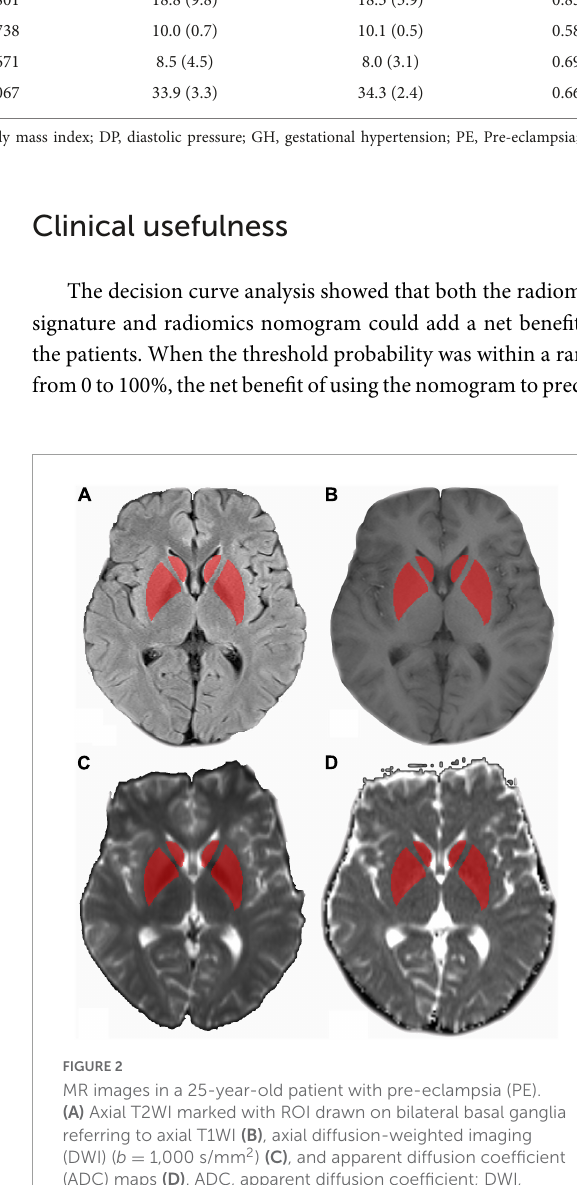
(ADC) maps (D) . ADC, apparent diffusion coefficient; DWI, diffusion-weighted imaging; T1WI, T1-weighted imaging; T2WI, T2-weighted imaging; ROI, region of